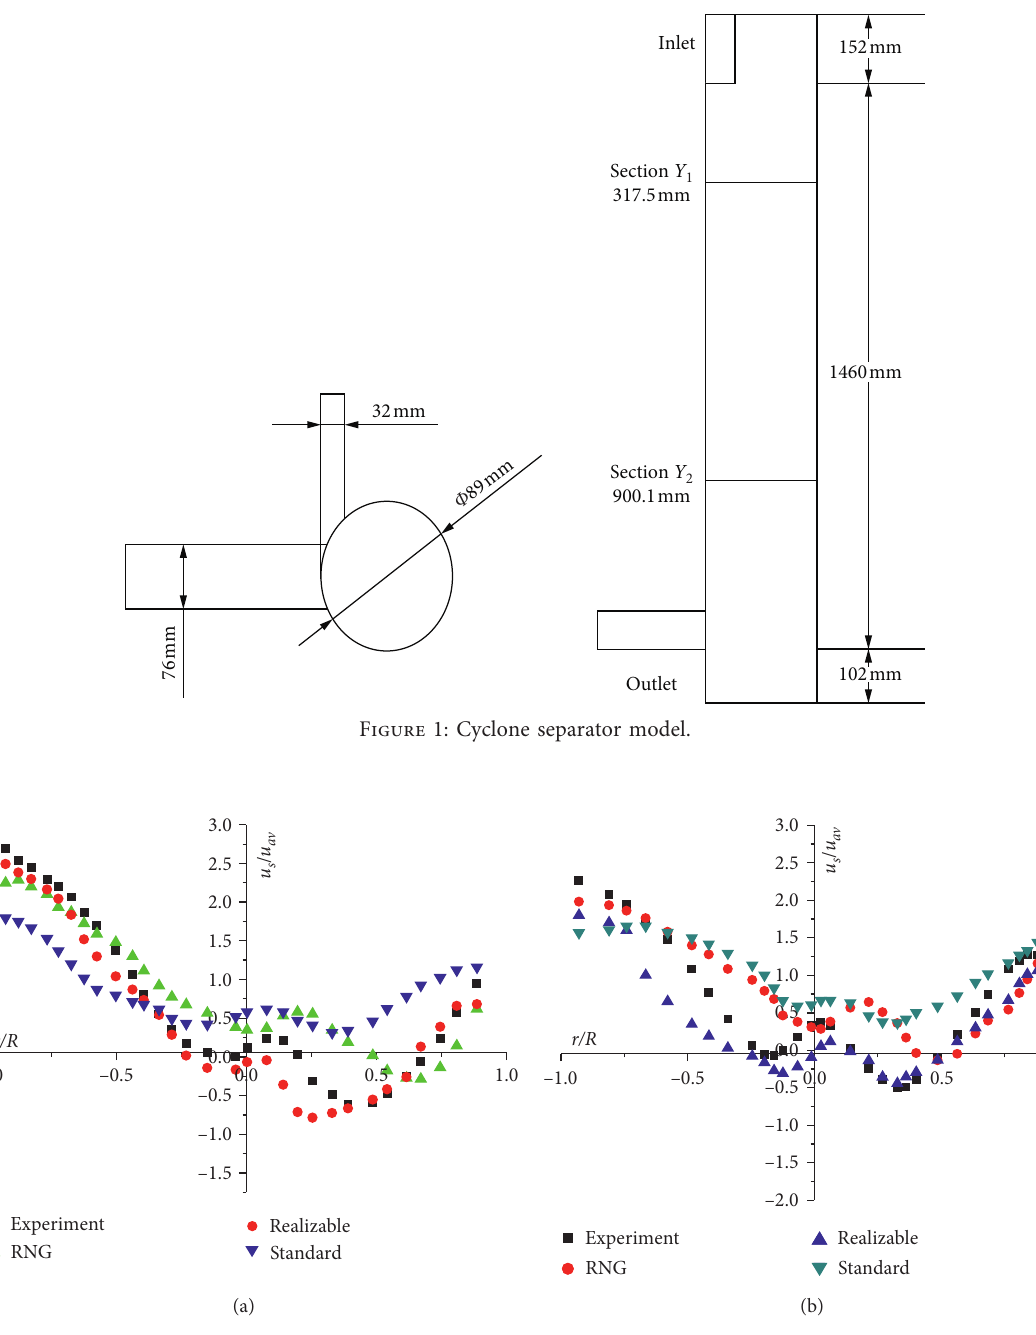
Figure 2: Axial velocity of each section. (a) Section 1. (b) Section